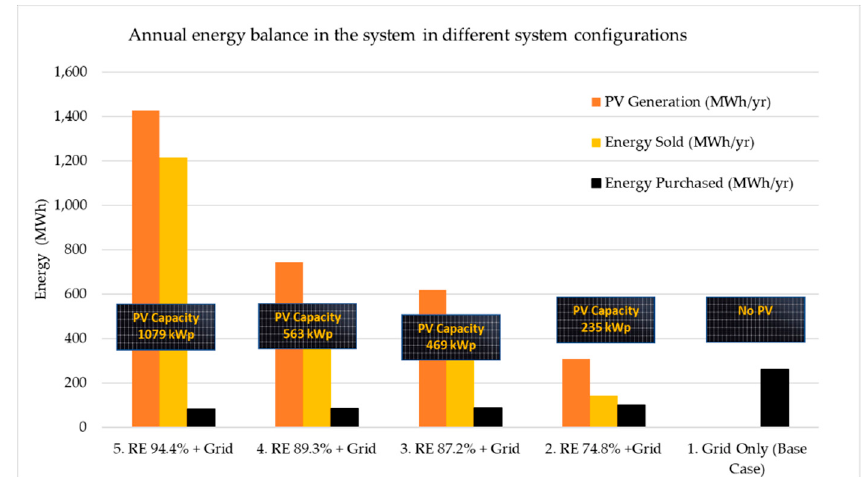
Figure 12. Annual energy balance in the systems in different system configurations.